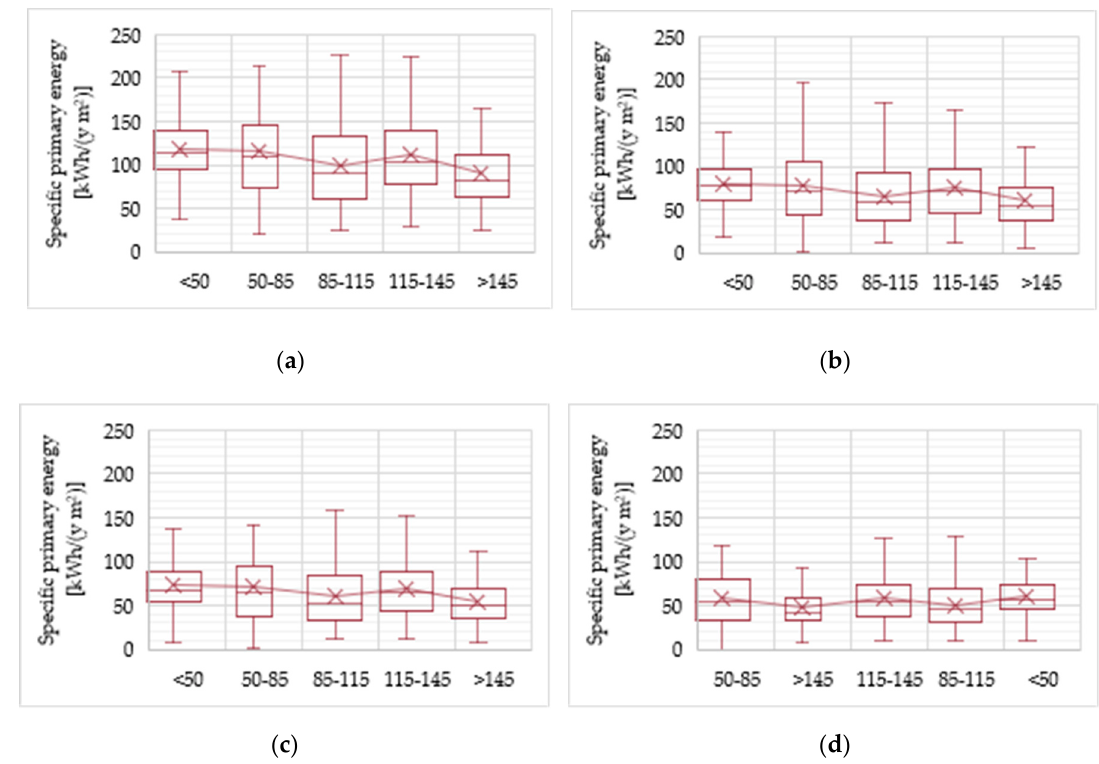
Figure 6. Specific consumption of primary energy for heating—Scenario #0. ( a ) Milan; ( b ) Florence; ( c ) Rome; ( d ) Naples.